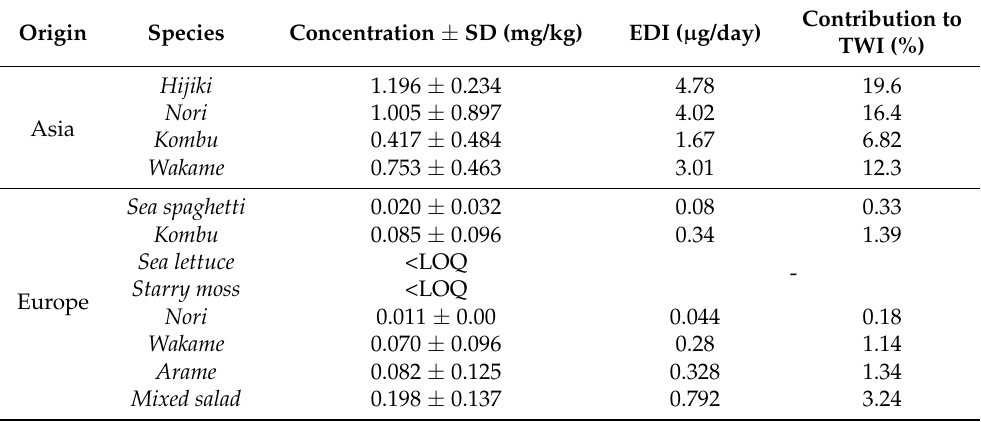
Table 4. Cadmium concentrations, estimated intake (EDI), and percentage contribution to the guideline value of the analyzed algae.